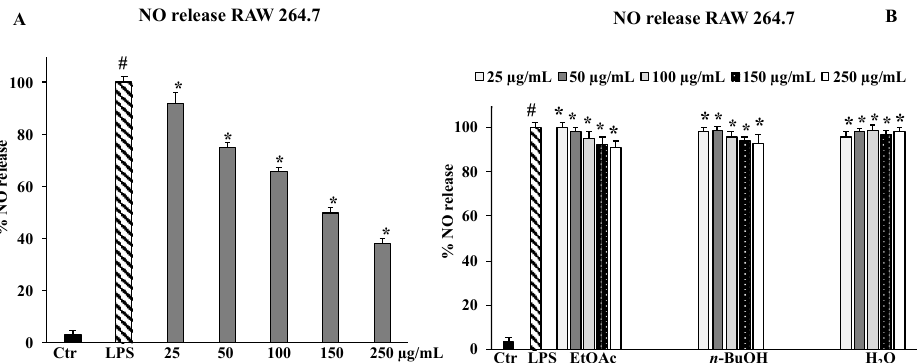
Figure 6. RAW 264.7 untreated cells (Ctr), LPS-treated for 2 h, and pre-treated with the total extract (25–50–100–150–250 μ g/mL) ( A ) and fractions (EtOAc, n -BuOH, H 2 O) ( B ) for 24 h. Values are the mean ± S.D. of five experiments in triplicate. Confidence intervals calculated by two-way ANOVA and Tukey post-hoc test: # Significant vs. untreated control cells: p < 0.001; * Significant vs. LPS-treated cells: p < 0.001.